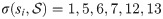
The procedure of Fair1 (Algorithm 4) when budgets are 1:2:3 and σ(si,S)=1,5,6,7,12,13 for i = 1, 2, …, 6.